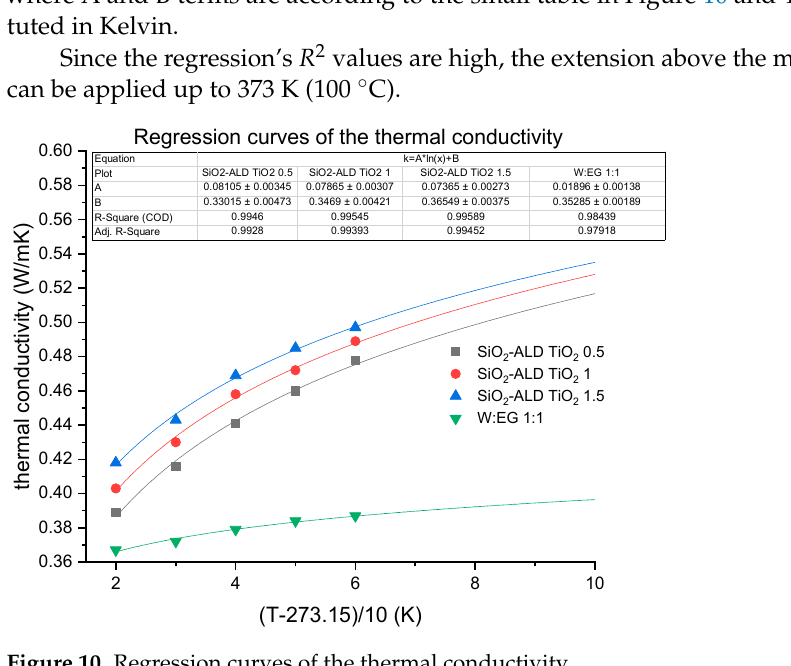
Figure 10. Regression curves of the thermal